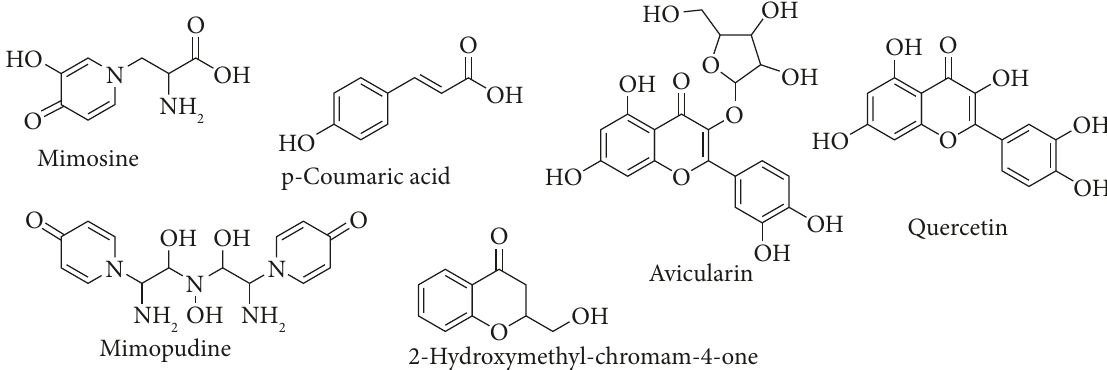
Figure 2: Structure of plant secondary metabolits from M . pudica